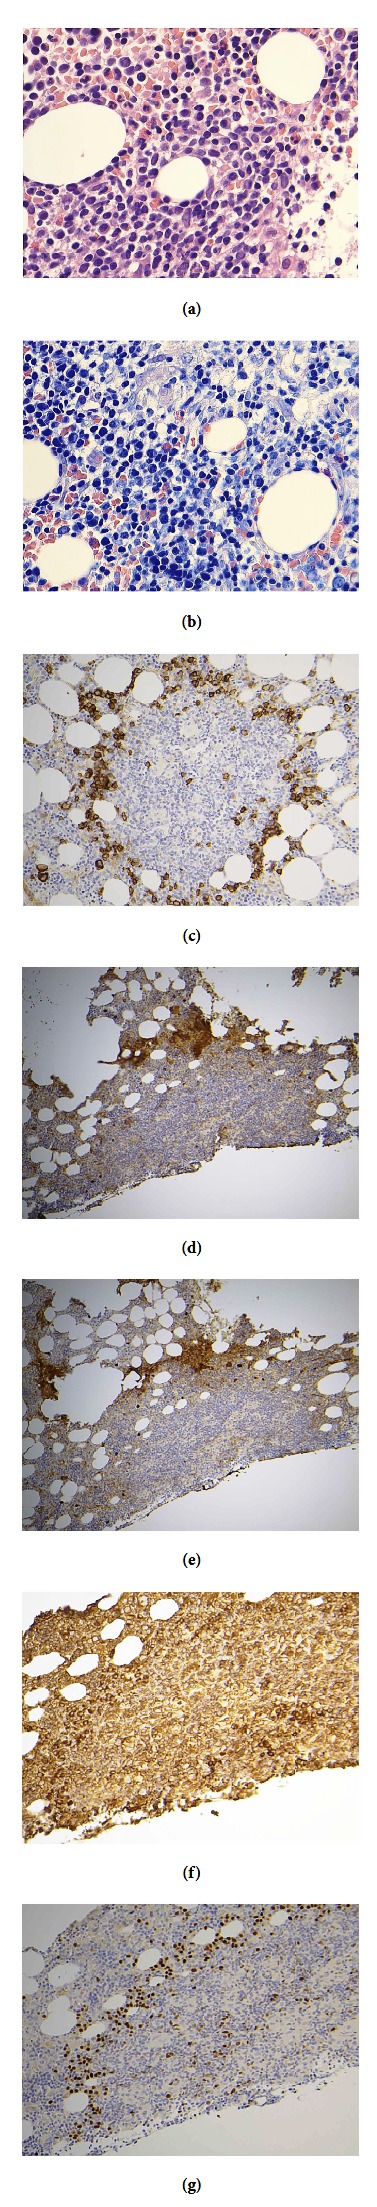
Bone marrow stain of Case 1. (a) Giemsa stain. (b) Small lymphocytes and scattered unusually small plasma cells. (c) CD138: plasma cells forming a characteristic corona around a lymphoid nodule. (d) Lambda stain—hardly any positive cells around the lymphoid nodule. (e) Kappa stain—hardly any positive cells around the lymphoid nodule. (f) IgG stain—a rim of strongly staining plasma cells. (g) Same area stained with MUM1 marker. Stains show there are IgG(+), kappa(−) and lambda (−) cells.